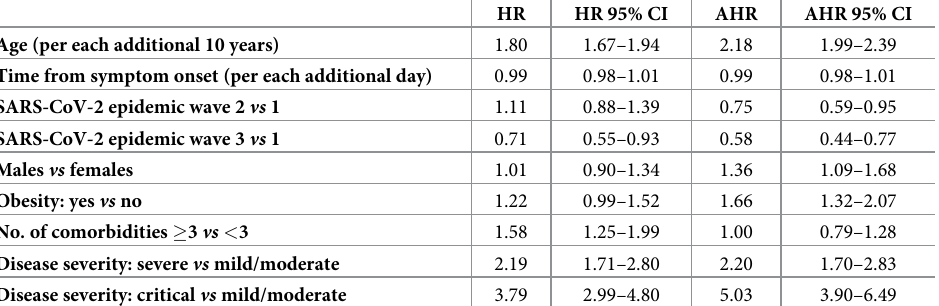
HR HR 95% CI AHR AHR 95% CI